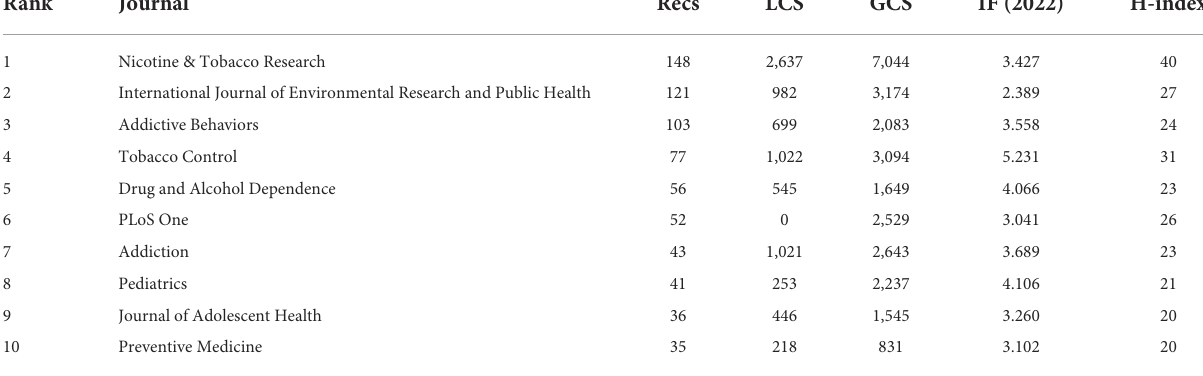
TABLE 4 The top 10 core journals on electronic cigarettes